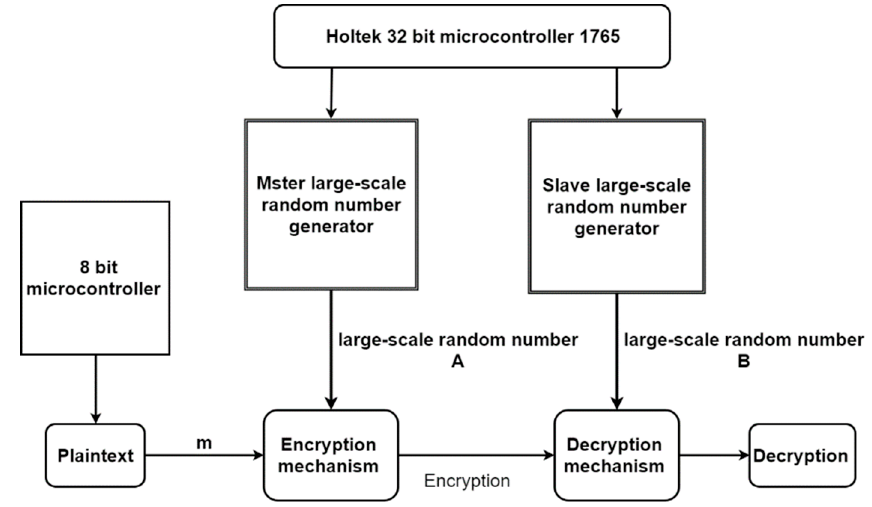
Figure 14. Communication system design diagram.